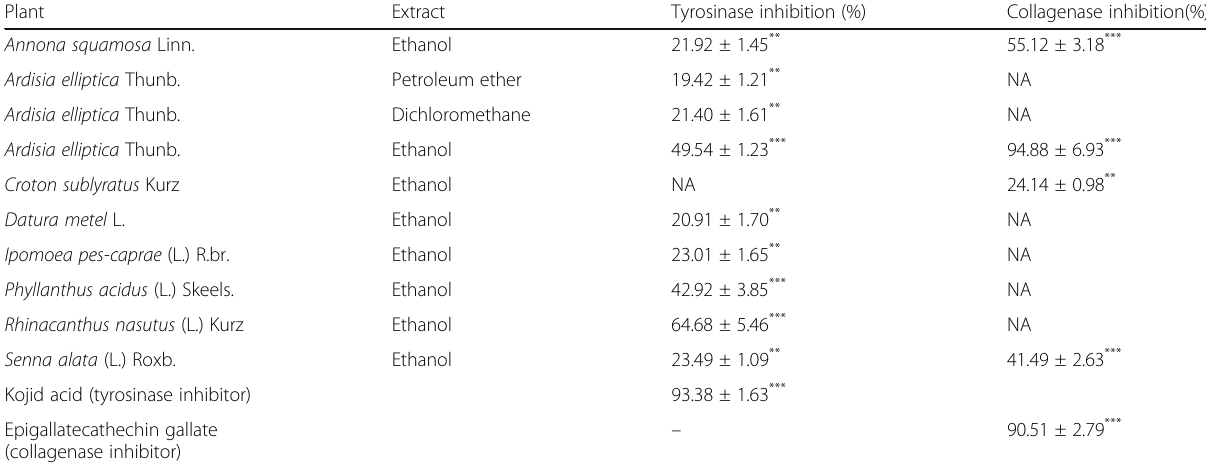
Table 5 Inhibition of tyrosinase and collagenase activities by Thai plant extracts